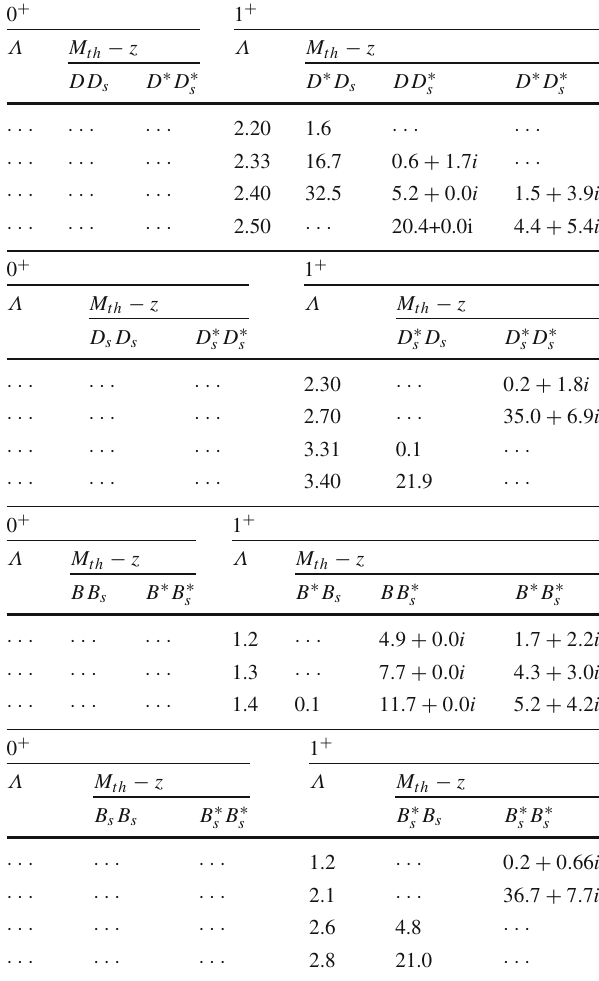
Table 8 The M th − z of the poles from the doubly heavy coupled- channel interaction. The cutoff Λ and M th − z are in units of GeV and MeV,